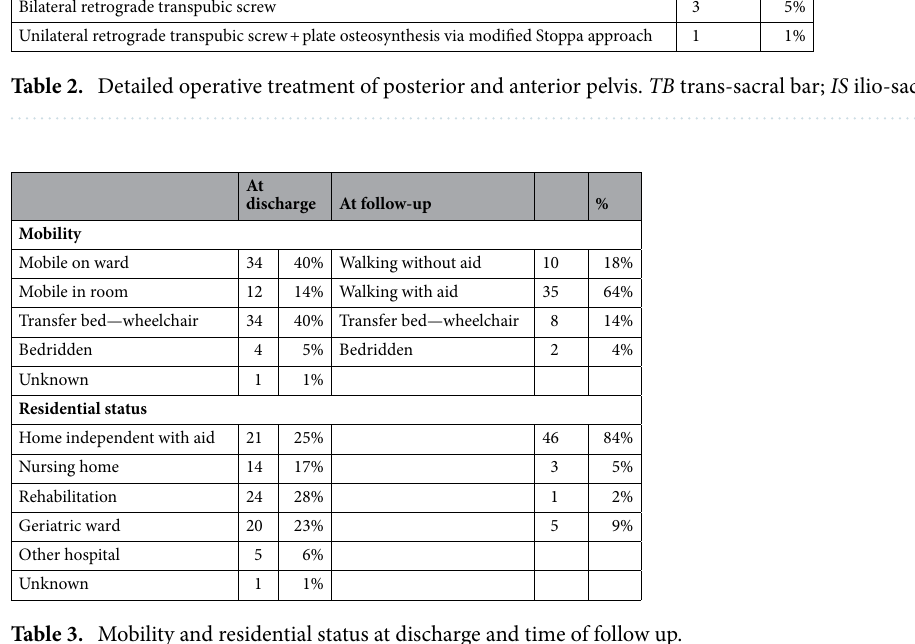
Table 3. Mobility and residential status at discharge and time of follow